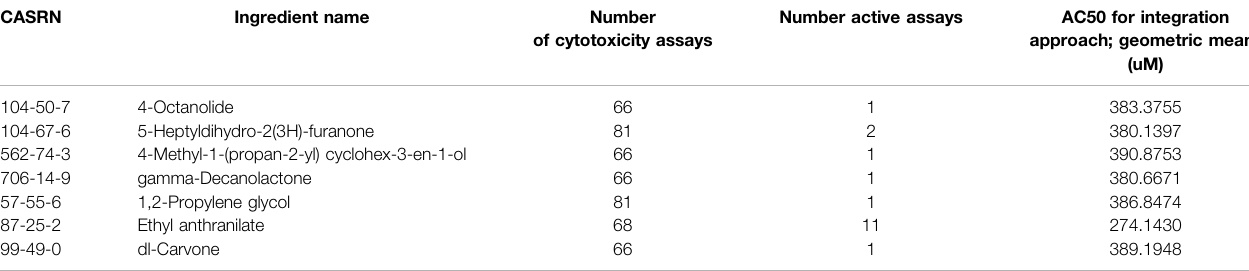
TABLE 1 | Ingredients treated as active in the integration analysis based on at least one active HTS cytotoxicity